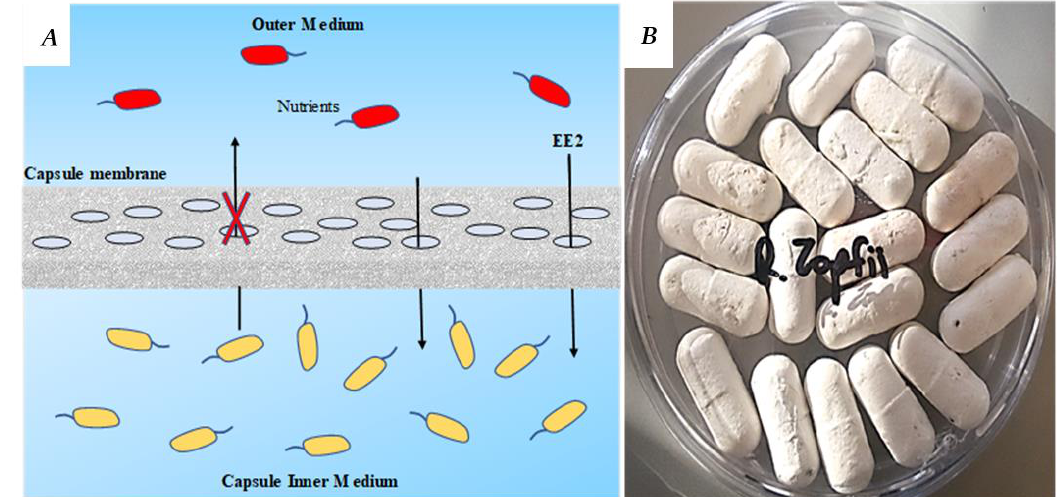
Figure 1. An illustration ( A ) and a picture ( B ) of a small bioreactor platform (SBP) membrane. The membrane allows the transport of dissolved molecules such as organics, nutrients and gases across the microfiltration membrane. ( A ) Schematic representation showing that the cellulose acetate microfiltration membrane of the SBP capsule holds the inner bacterial culture suspension, while 17 α -ethynylestradiol (EE2) (as a model micropollutant in this study) and other nutrients diffuse freely into and out of the capsule body. The red bacteria represent bacteria in the mixed liquor, while the yellow bacteria represent the encapsulated EE2-degrating bacteria. ( B ) A photograph of SBP capsules encapsulating R. zopfii in a dry state, prior to the activation stage.